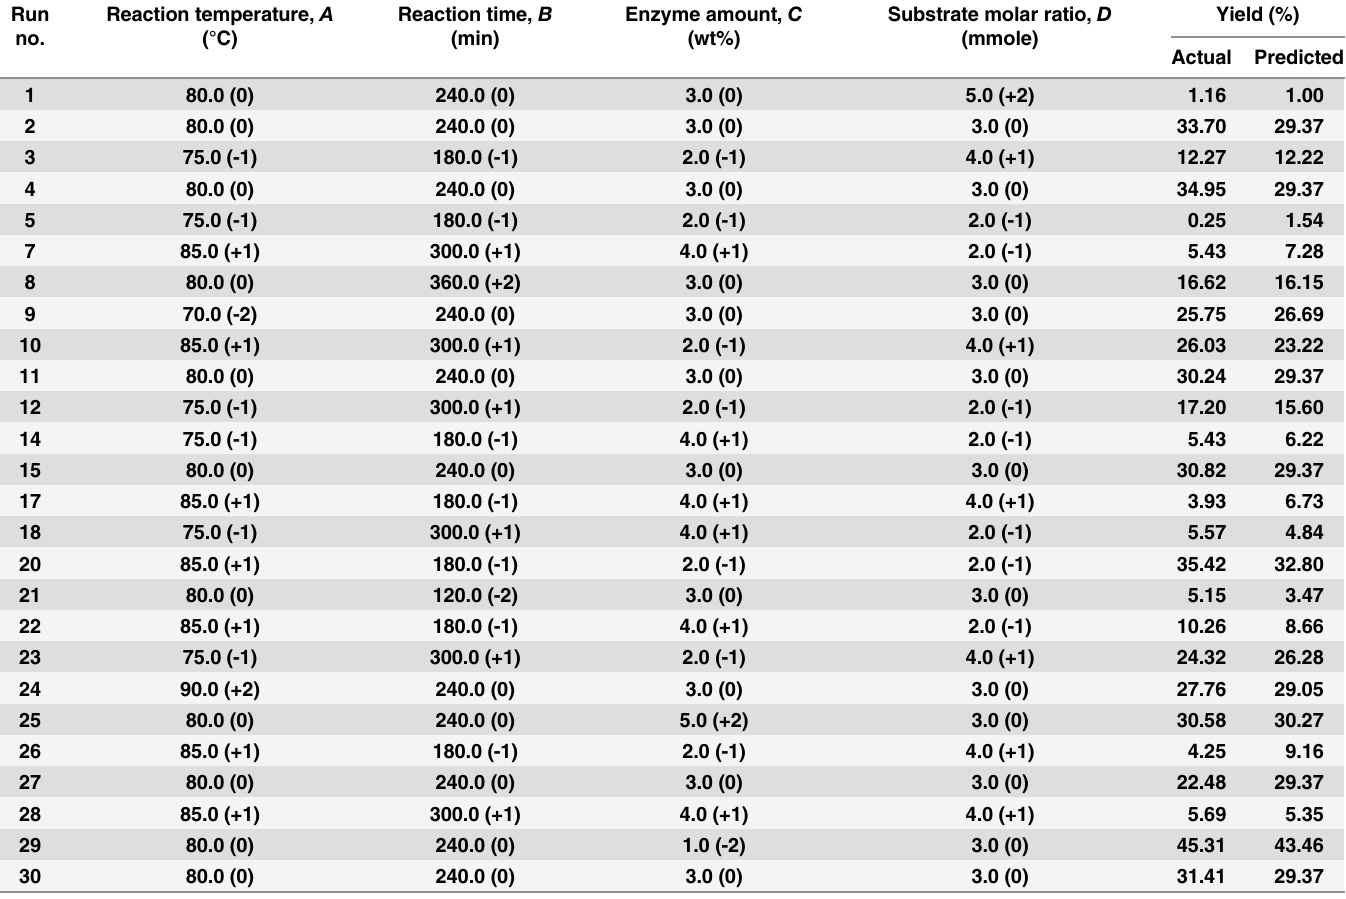
Table 2. Central composite rotatable design of KMO